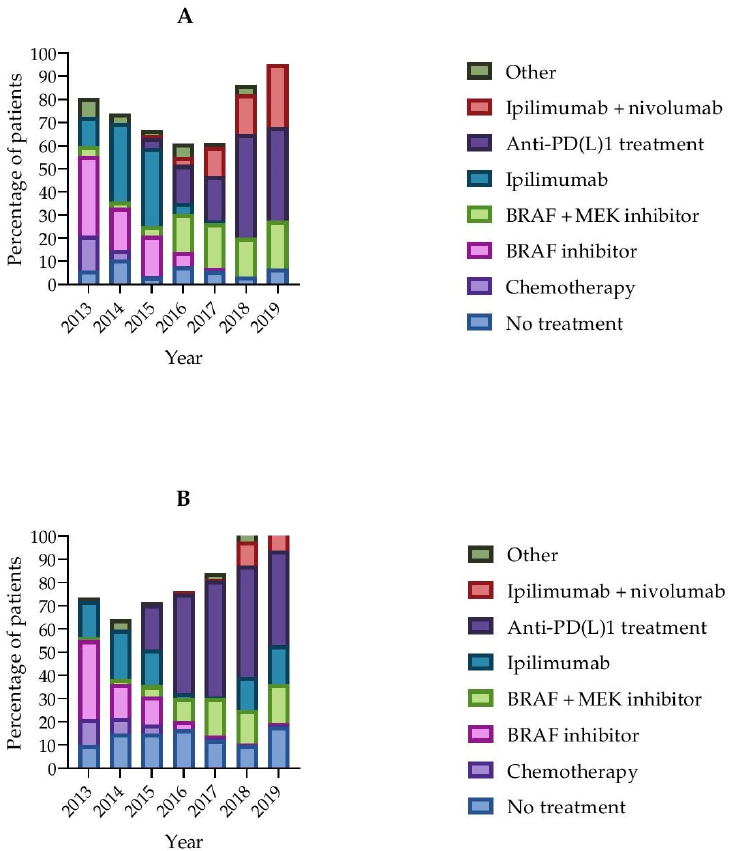
Figure 1. Changes in treatment strategies over time per age group: ( A ) patients aged 65–74; ( B ) patients aged 75 years and older.